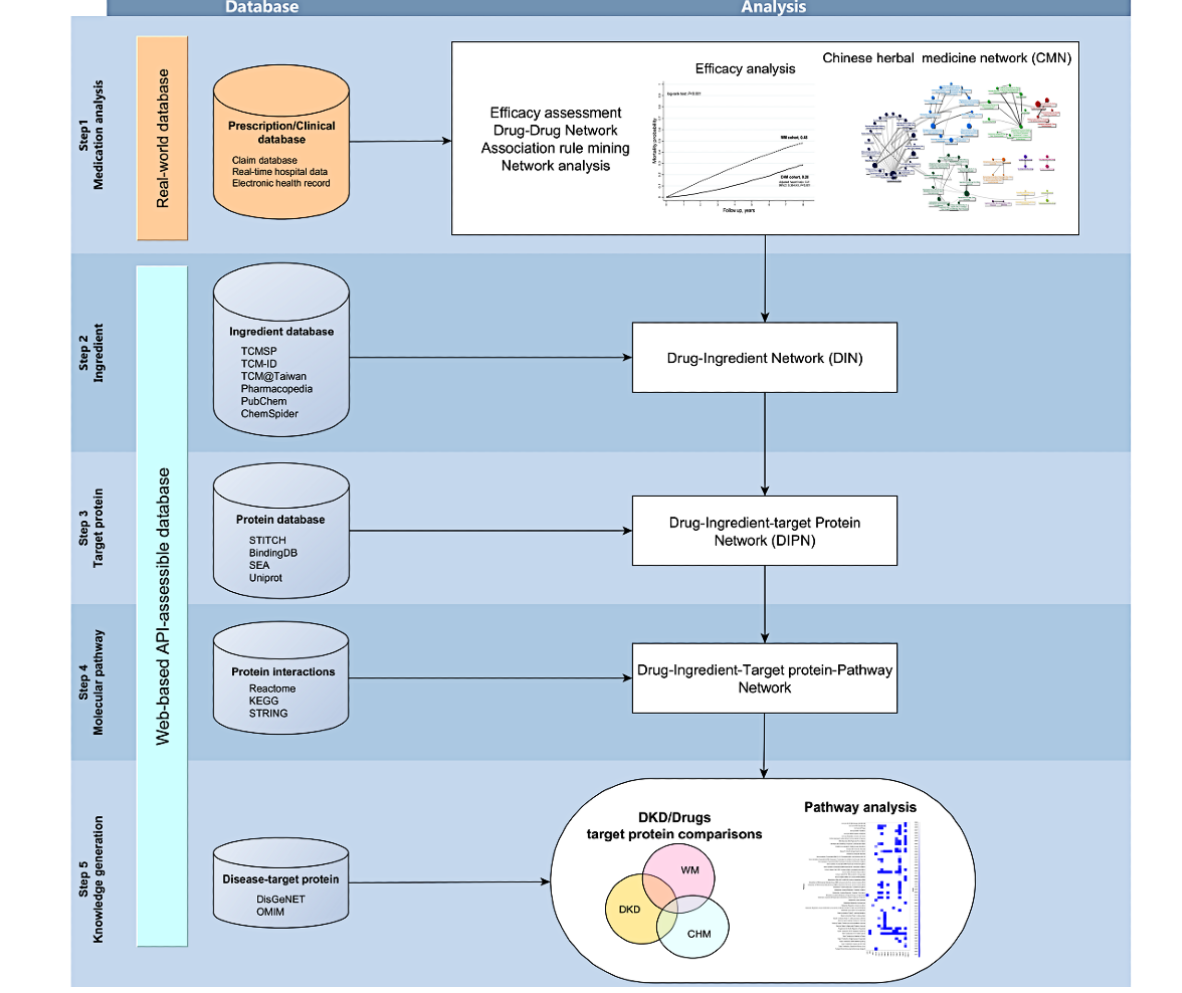
Figure 2. Data processing framework. API: application programming interface; DKD: diabetic kidney